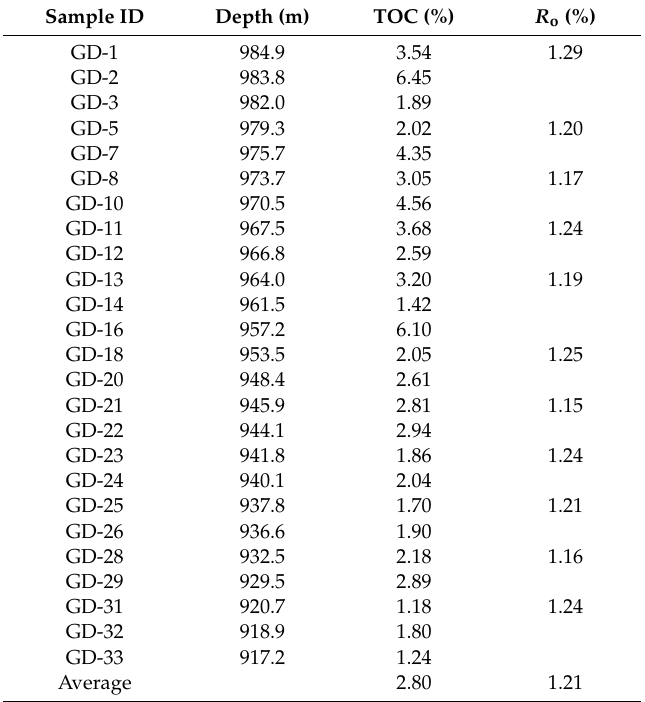
Table 2. Organic abundance and maturity of the Dalong Formation